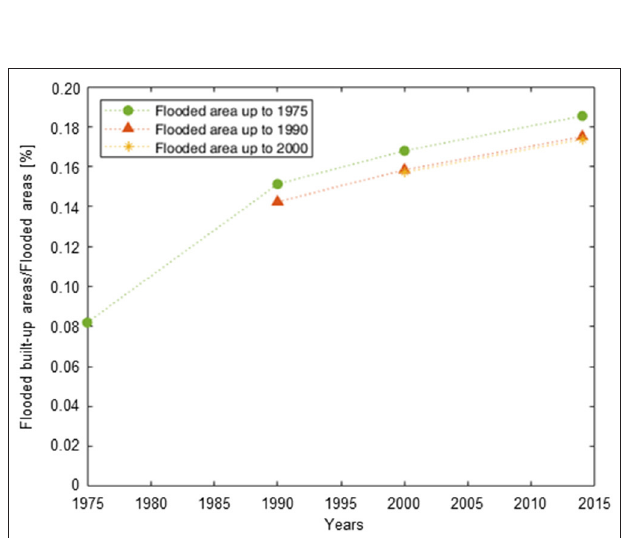
FIGURE 5 | Flood memory assessment across the MDB from 1973 to 2014: temporal evolution of the ratio between built-up areas in previously flooded areas and flooded areas (as %) up to 1975 (green circles), up to 1990 (orange triangles), up to 2014 (yellow stars).